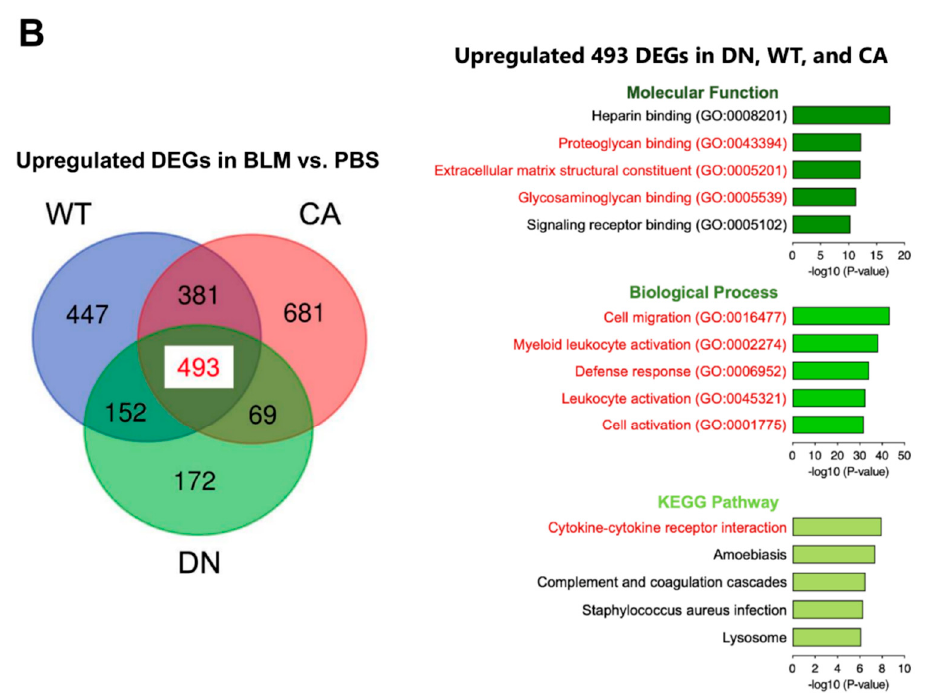
Figure 3. Gene ontology (GO) and Kyoto Encyclopedia of Genes and Genomes (KEGG) pathway enrichment analysis of differentially expressed genes (DEGs) altered by BLM treatment among three mouse groups. ( A ) K-means clustering shown in a heatmap based on the gene expression profiles between the BLM- and PBS-treated groups of three mouse genotypes (left). The colored bars on the right of the diagram indicate clusters. The trees represent enriched KEGG pathways corresponding to each cluster (right). ( B ) Venn diagram showing the overlap of DEGs upregulated by BLM among three mouse groups, with the numbers of DEGs indicated in each area (left). GO and KEGG pathway enrichment analysis of 493 common upregulated DEGs among the three genotypes (right). Top five enriched GO terms associated with molecular function (upper) and biological process (middle), and KEGG pathway analysis